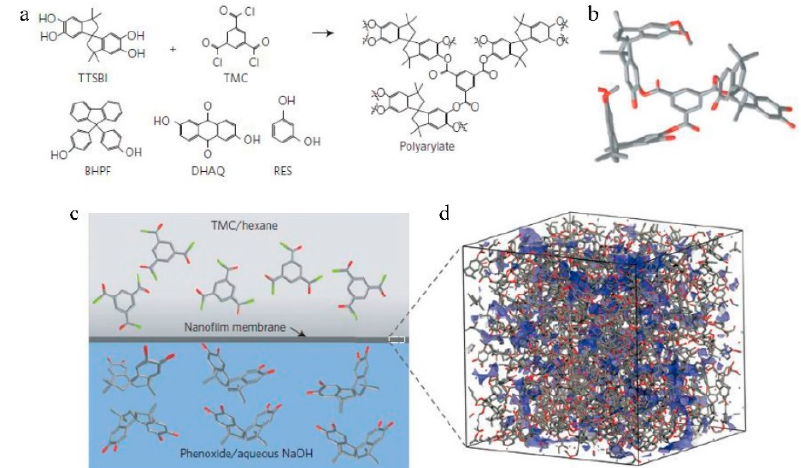
Figure 11. Interfacial synthesis of polyarylate nano-films. ( a ) Synthesis of aromatic polyester (polyarylate) nano-films through interfacial polymerization. The aromatic phenol is dissolved in a dilute sodium hydroxide solution and reacts with trimesoyl chloride (TMC) dissolved in hexane at the hexane/aqueous interface. Four different phenol monomers were used including spiro-structured 5,50,6,60-tetrahydroxy-3,3,30, 30-tetramethylspirobisindane (TTSBI), cardo-structured 9,9-bis(4-hydroxyphenyl)fluorene (BHPF), and planar-structured 2,6-dihydroxyanthraquinone (DHAQ), and 1,3-benzenediol (RES). The cardo-structured and spiro-structured monomers are contorted, rigid monomers. DHAQ and RES are monomers with planar structures. ( b ) Molecular model of a segment of polyarylate network containing spiro-contorted monomers from TTSBI. ( c ) Visualization of the interfacial polymerization between TMC in hexane and the phenoxide of TTSBI in aqueous NaOH solution. ( d ) Three-dimensional view of an amorphous cell containing a spiro-contorted PAR-TTSBI polyarylate network. Blue color: accessible surface at probe radius of 1 Å. Cell size: 46 Å × 46 Å × 46 Å. Reproduced from Reference [39]. 4. Surface area of microporous materials.